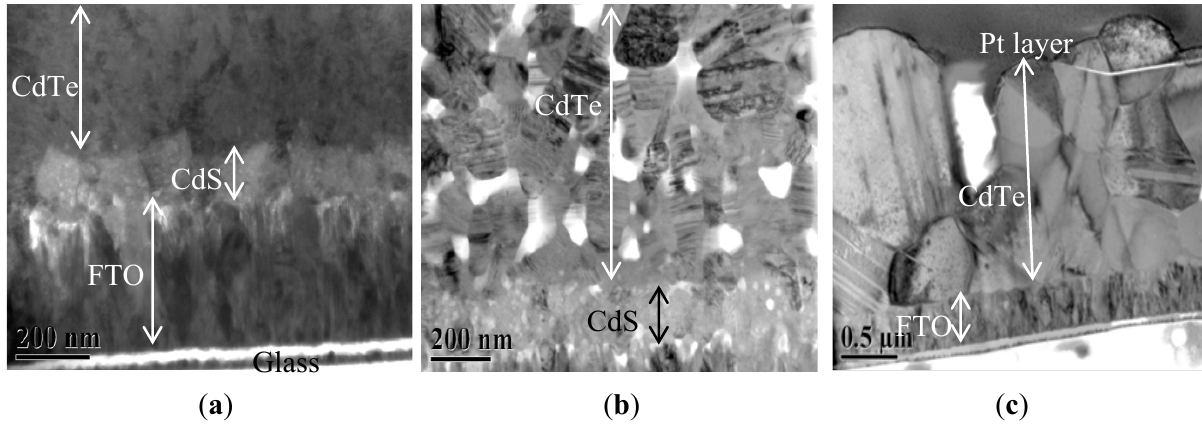
Figure 8. Transmission Electron Microscopy (TEM) images of ( a ) as-deposited glass/FTO/CdS/CdTe; ( b ) heat-treated structure with 0.01% CdCl ; and ( c ) heat-treated 2 structure with 1.0% CdCl for comparison. Note the formation of large grains comparable 2 to CdTe layer thickness and complete absorption of the CdS layer into CdTe layer under this